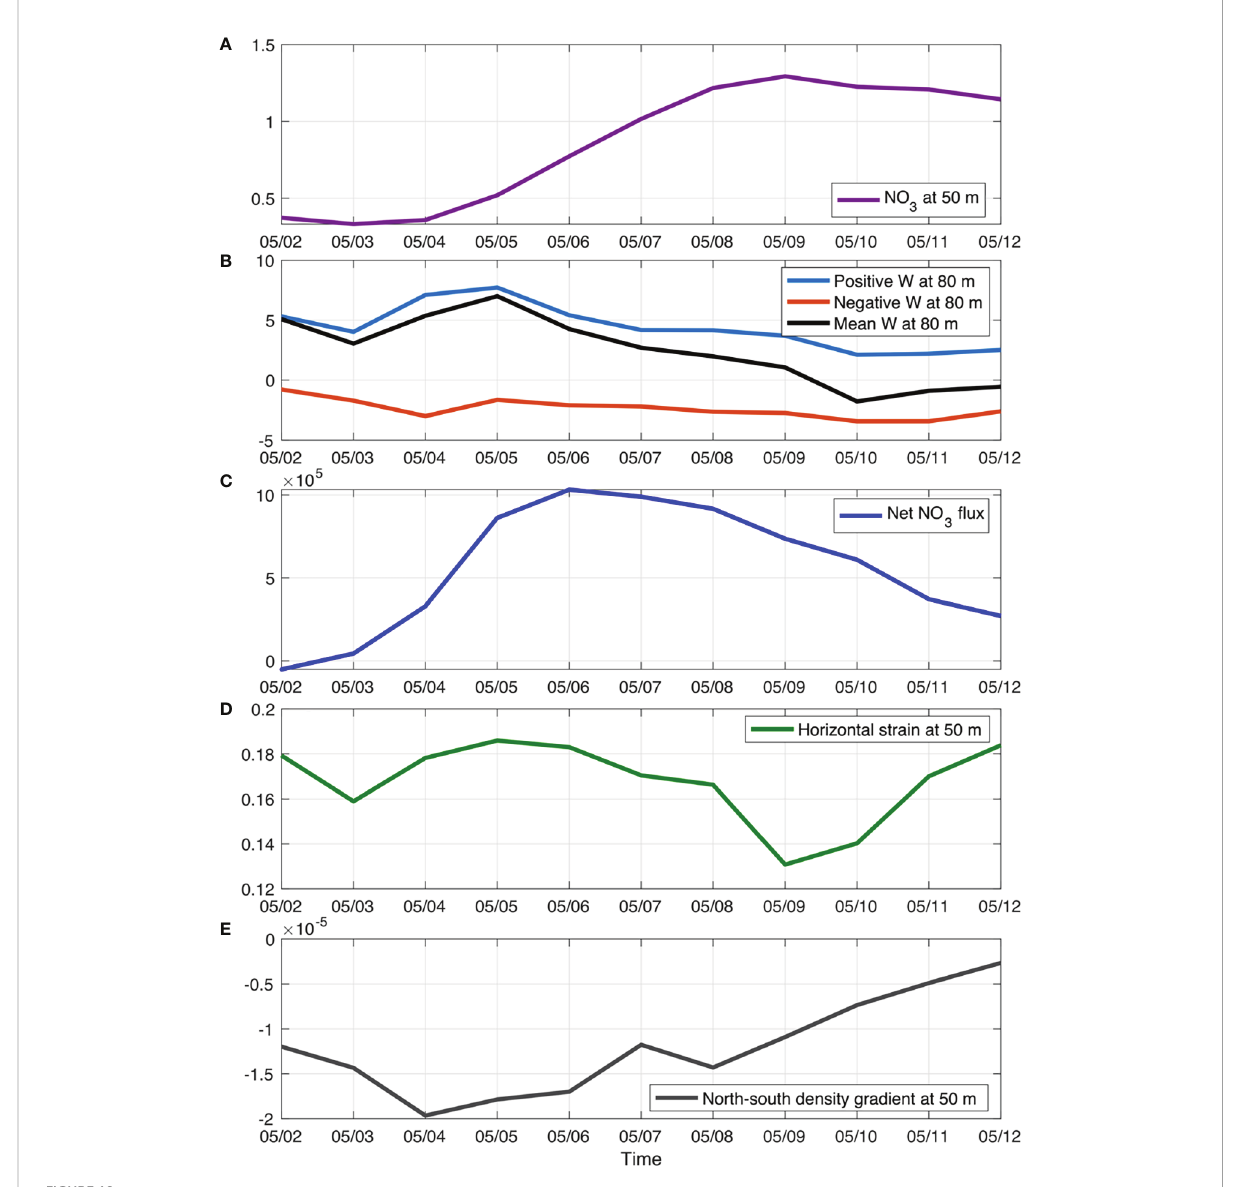
FIGURE 10 Temporal variations of box-averaged nitrate concentration (A ; unit: mmol m -3 ) , vertical velocities ( B ; units: m d -1 ), net nitrate advection fl ux (C ; unit: mmol s -1 ) , normalized horizontal strain by f (D) , and north-south density gradient (E ; unit: kg m -4 ) of case2